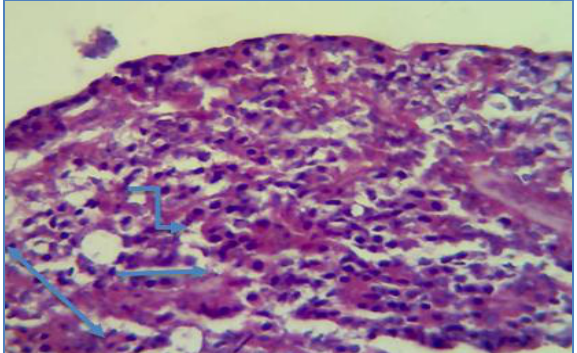
Figure, 9: Section in testis of control group shows normal architecture of seminiferous tubules ( ) (H and E stain